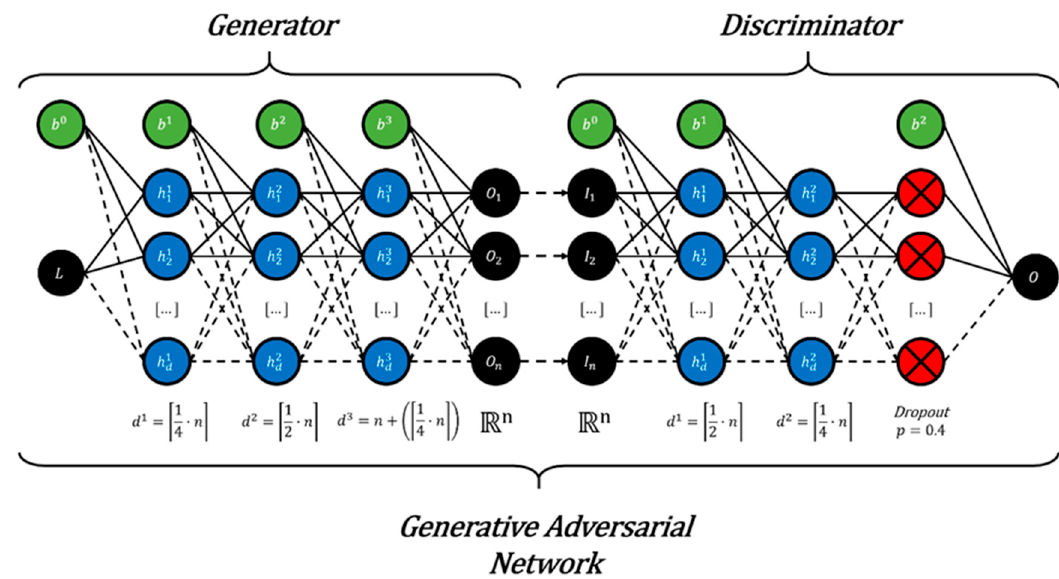
Figure 4. Descriptive figure presenting the optimal GAN architecture for geometric morphometric data augmentation. Input ( I ) and output ( O ) neurons are represented in black with bias ( b ) in green. The output of the generator and the input of the discriminator is represented by the n number of dimensions in the R n dimensional target feature space. The latent vector ( L ) input for the generator must be adjusted according to the dimensionality of the target feature space. Hidden neurons ( h ) in layers h n have a density ( d ) that is also conditioned by the shape of the target distribution. Finally, the discriminator has an additional dropout layer (red) with a threshold of p = 0.4.